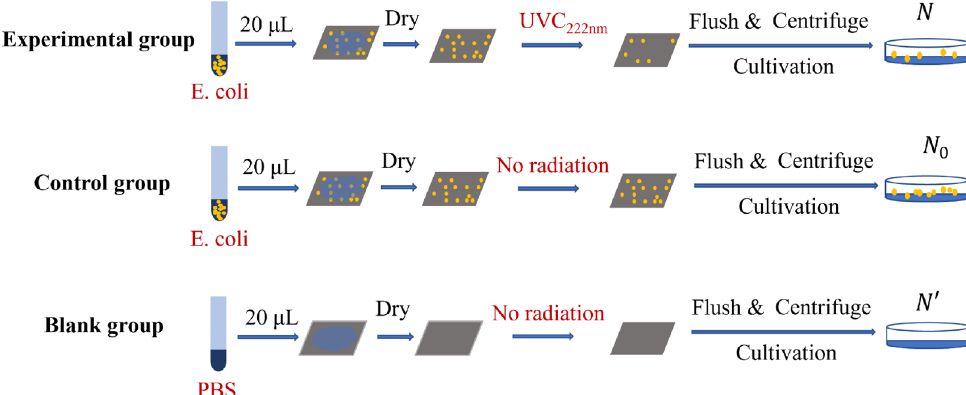
Figure 10. Schematics for measuring the inactivation efficiency of E. coli with three parallel test